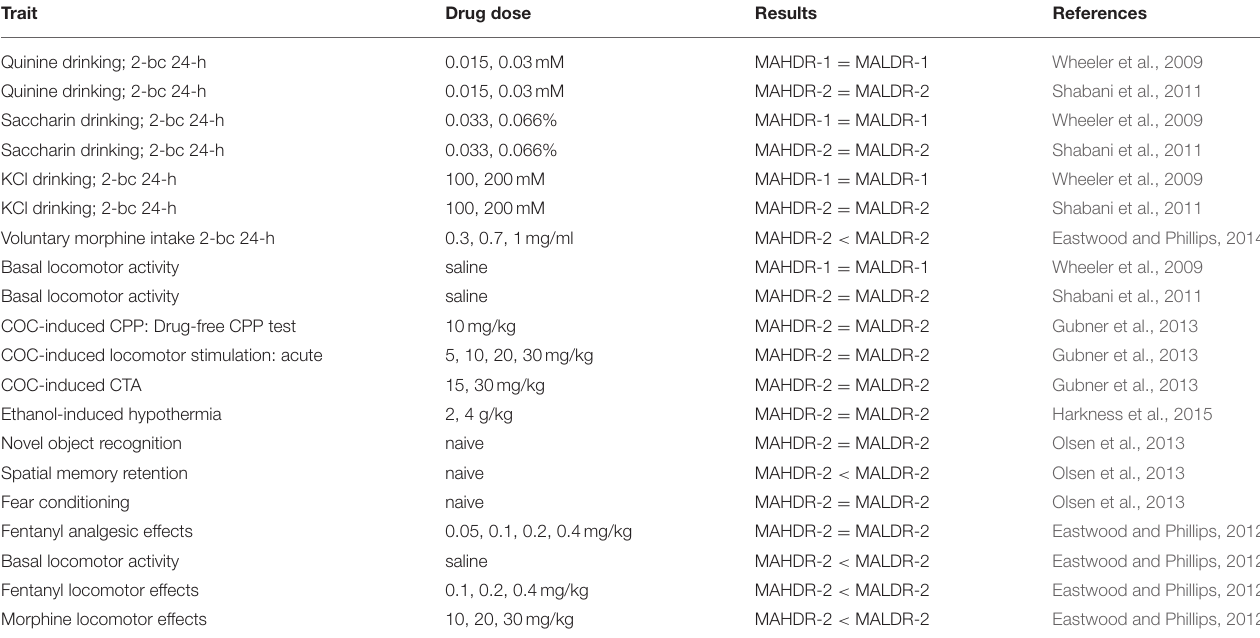
TABLE 2 | Published non-MA traits characterized in the MA drinking lines.